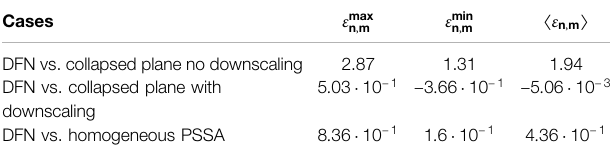
TABLE 4 | Results of the mass test for the different variant simulations of the Decay Chain case . The test is run for each DFN realization and related collapsed plane or homogeneous model and the results are provided in terms of maximum ( ε